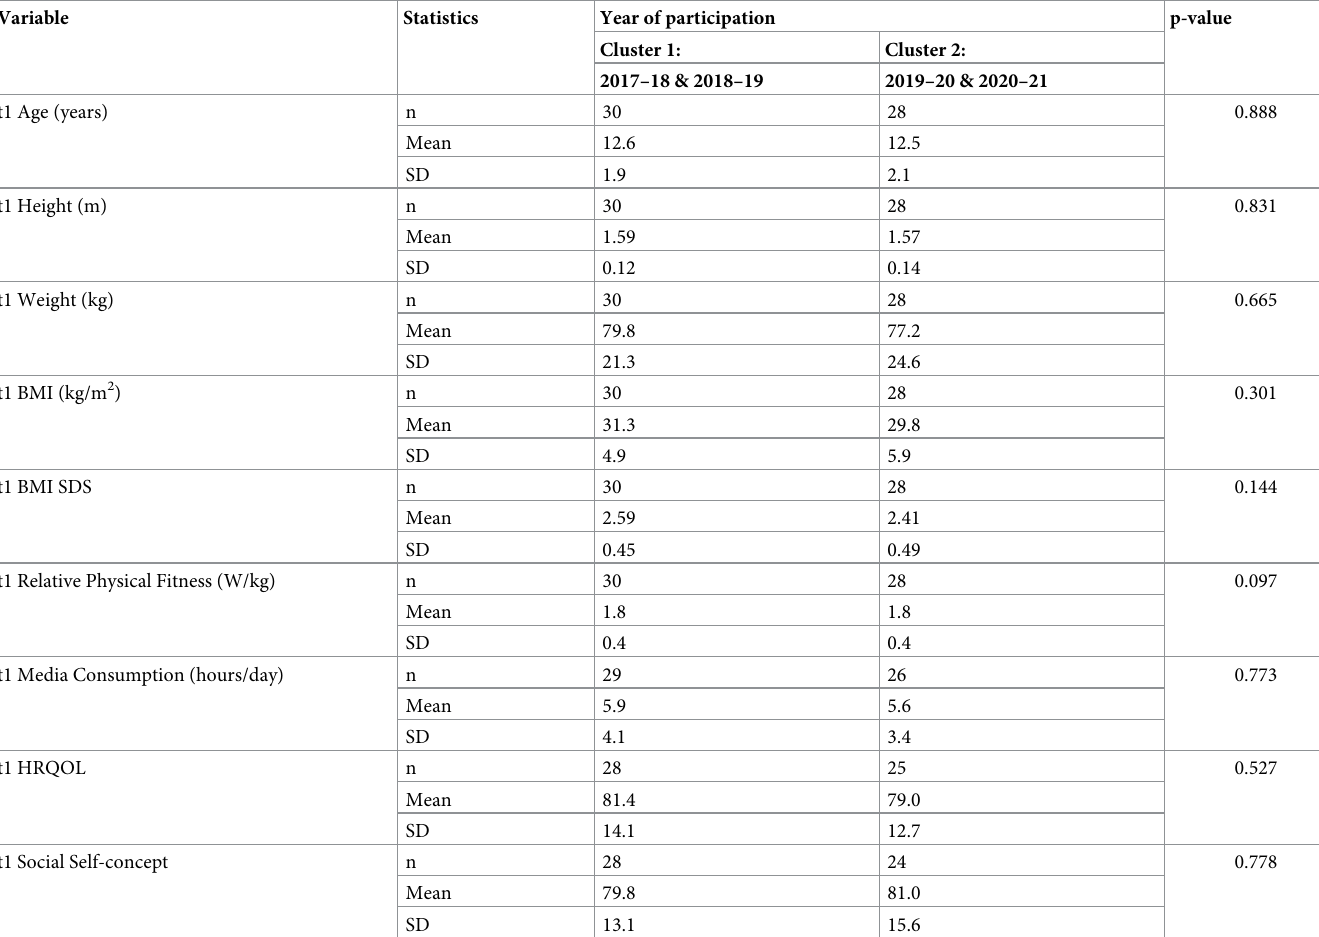
Table 2. Baseline differences between the program participants before and during the pandemic.